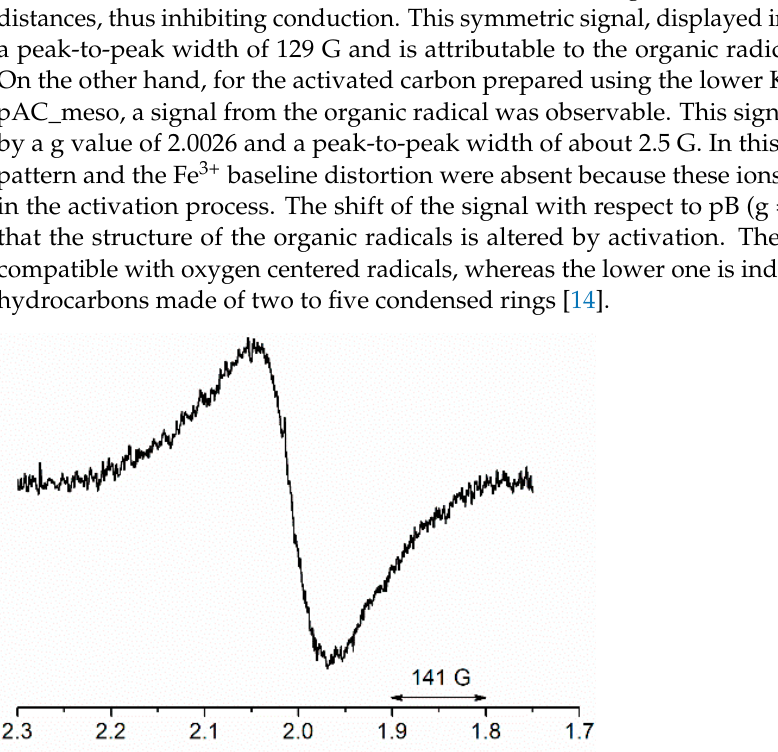
Table 2. Organic radical content of the samples examined.